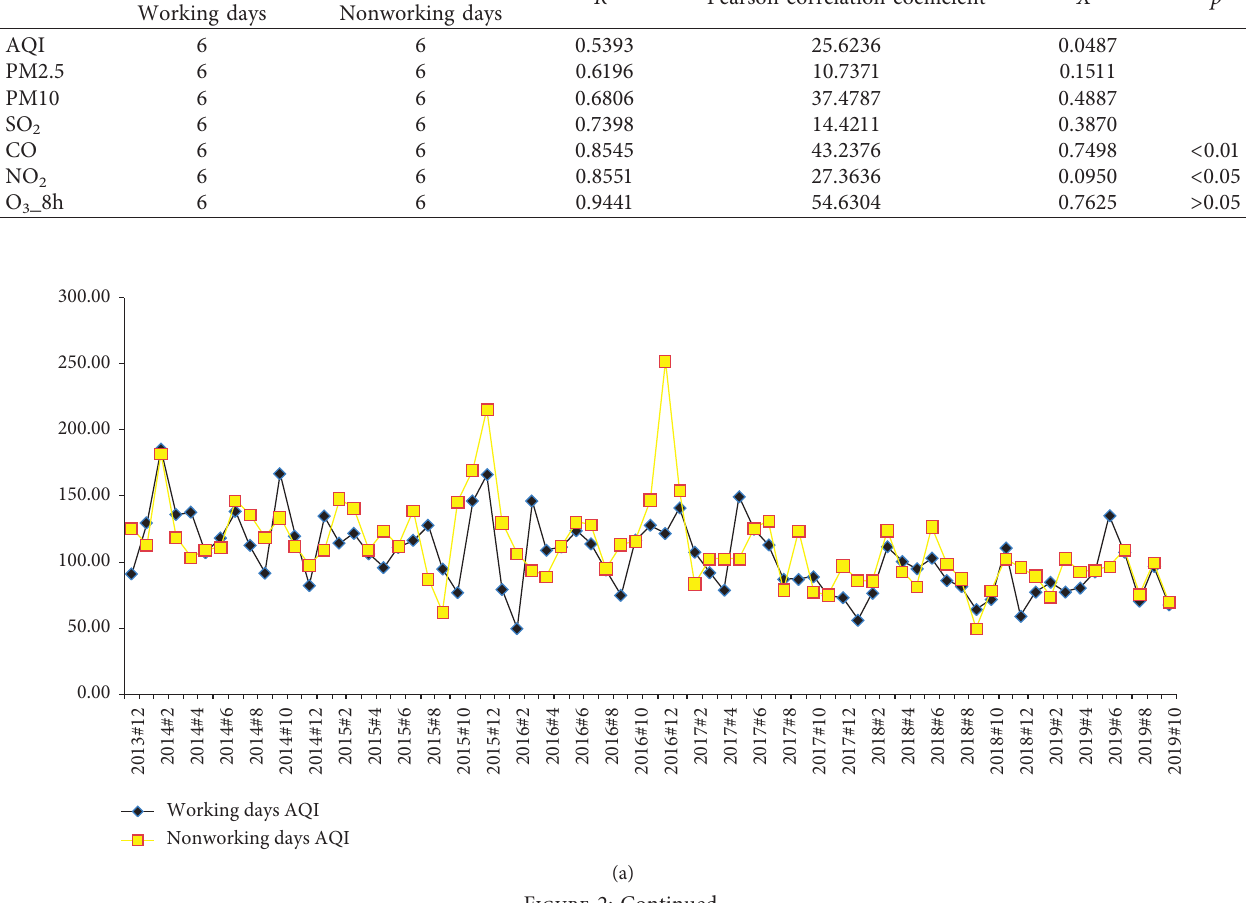
Figure 1: Comparison with the tail number of 4 and 9 and tail number of non-4 and 9. Table 3: Pearson correlation analysis of working days and nonworking days. Peaks and valleys (n) Pearson correlation coefficient